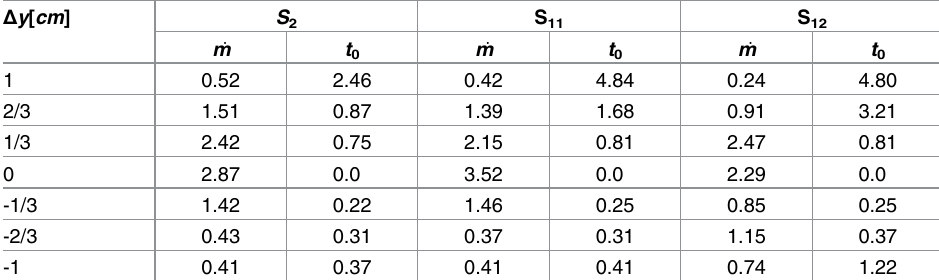
Table 5. Drug accumulation rate (1/s) and appearanceinstant (s), as obtained by varying the injection speed. Δ y [ cm ] S 2 S 11 m